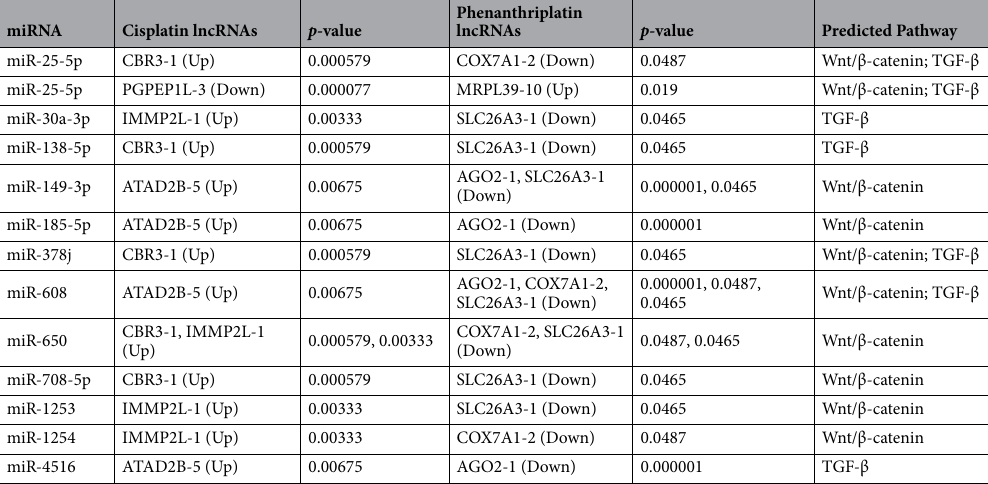
Table 3. MiRNAs projected to target regulated lncRNAs in A549 cisplatin and phenanthriplatin treated cells and predicted pathway signaling ( p ≤